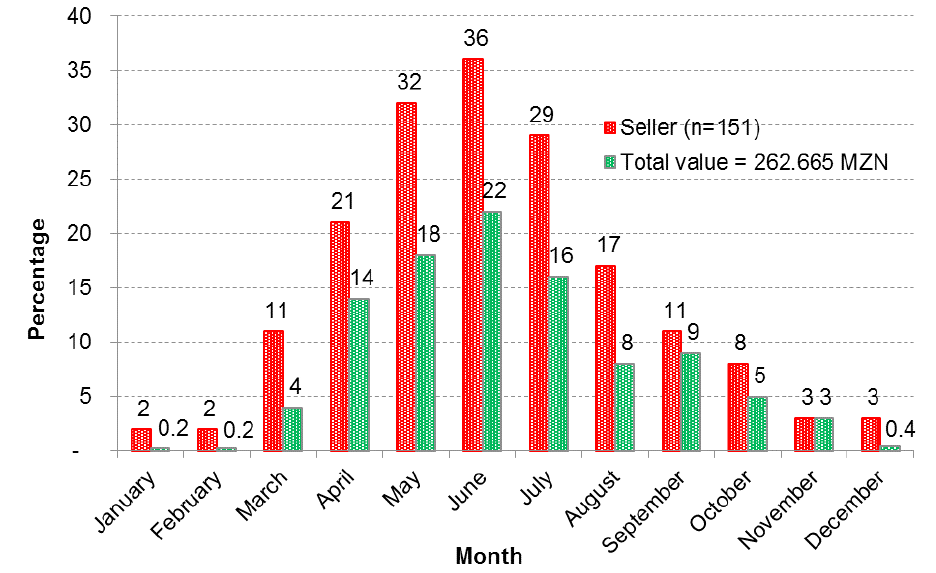
Figure 15: OFSP selling period and return in